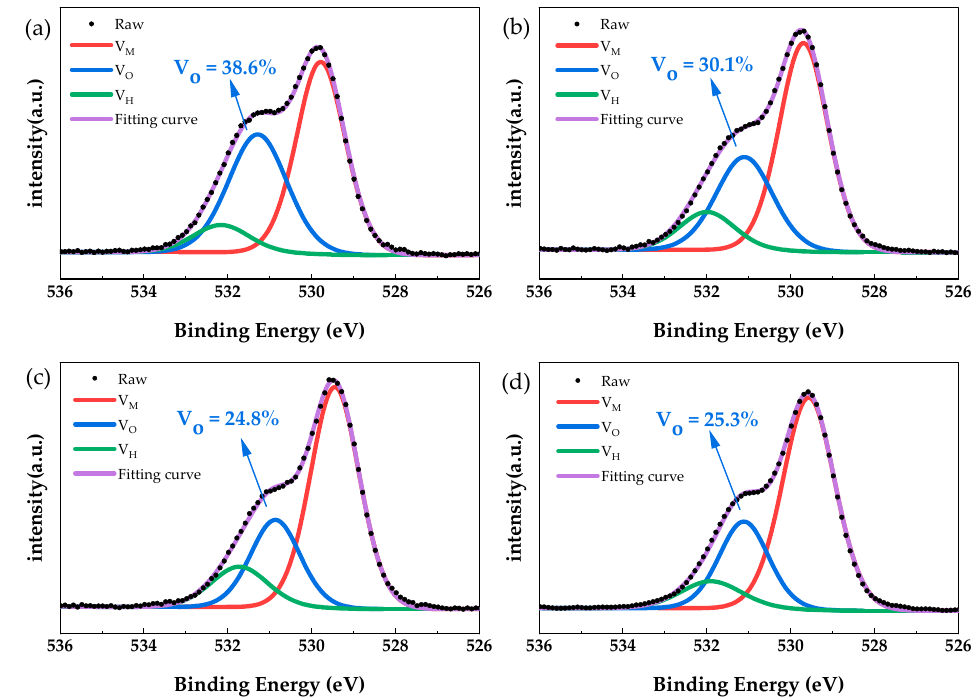
Figure 6. The O 1s spectra of PrIZO thin films with different oxygen partial pressures: ( a ) 0%, ( b ) 5%, ( c ) 10%, ( d )